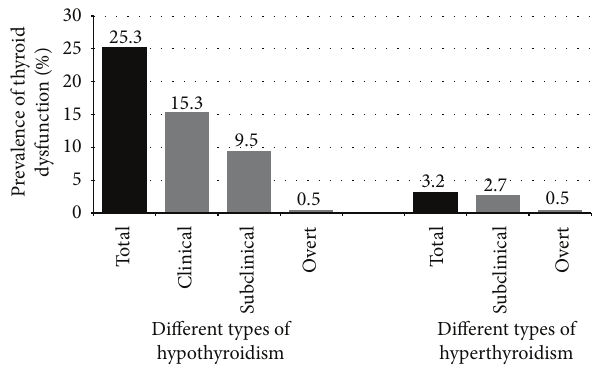
Figure1:Prevalenceofdifferenttypesofthyroiddysfunctionamong Type 2 diabetic Saudi patients. Clinical hypothyroidism for patients receiving thyroxin treatment, and Subclinical hypothyroidism when TSH > 5.0 mIU/L with normal T4 (10.55–25.74 pmol/L), while overt hypothyroidism when TSH > 5.0mIU/L with low T4 < 10.55 pmol/L. Subclinical hyperthyroidism when TSH < 0.5mIU/L with